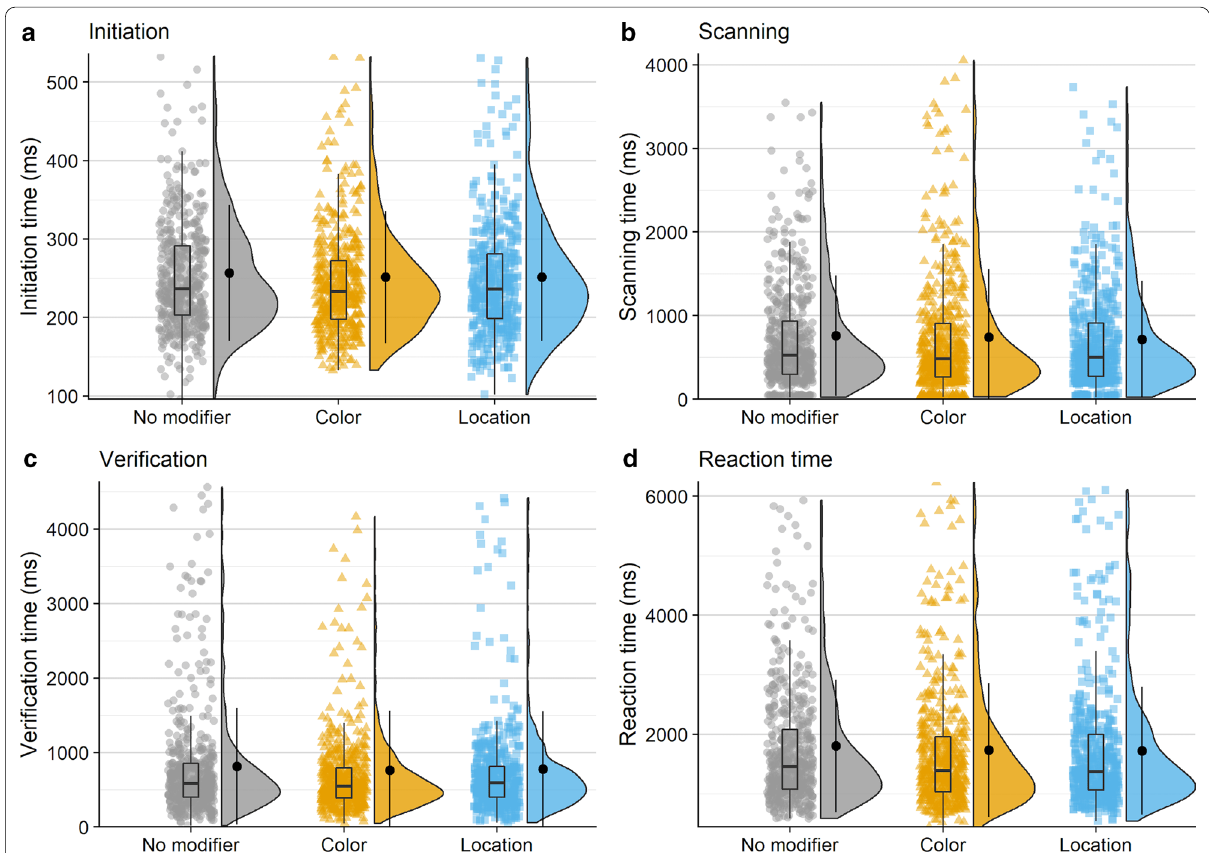
Fig. 8 Raincloud plots depicting data for Experiment 2, oriented vertically for legibility. Points on the left side of each raincloud show raw data. Box plots, superimposed over the raw data, indicate the median value (middle horizontal line), the first and third quartiles (top and bottom lines in box), and 1.5 the interquartile range: the distance between the first and third quartiles (whiskers). Violin plots show the range (minimum and × maximum) and density (width) of the data. Isolated points on the right side of each raincloud indicate the mean, and error bars on said points reflect one standard deviation. For ease of visualization, the bottom 99% of the data are shown